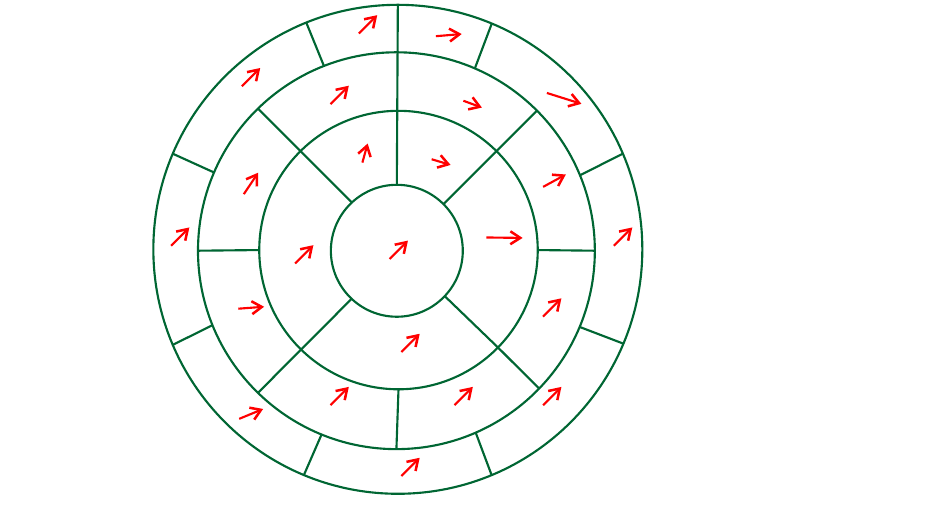
Figure 3. Representation of the CMV determination in each sector of the sky-camera